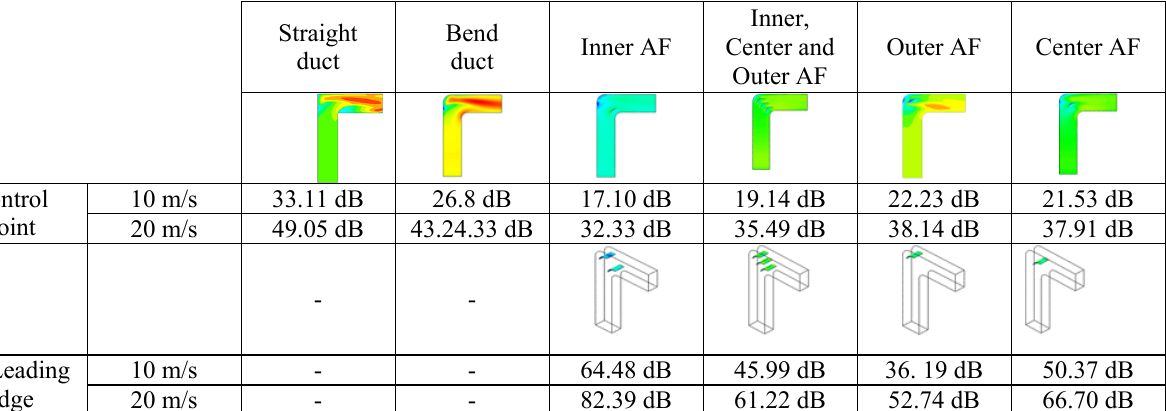
Table 2. Empirical constants in the standard k- ε model